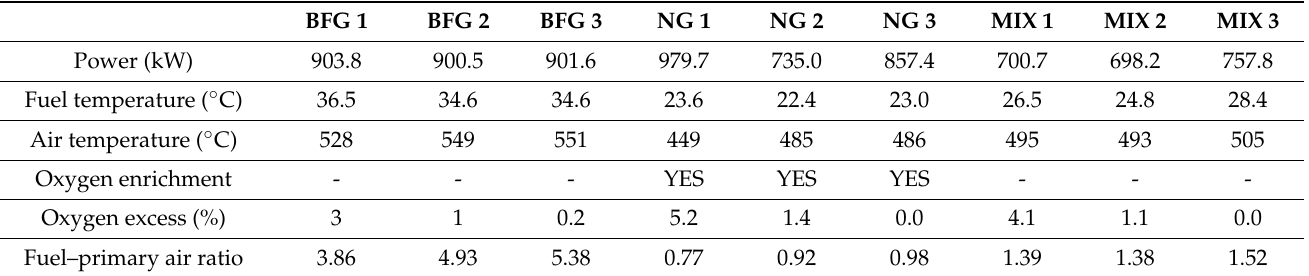
Table 4. Matrix of tested